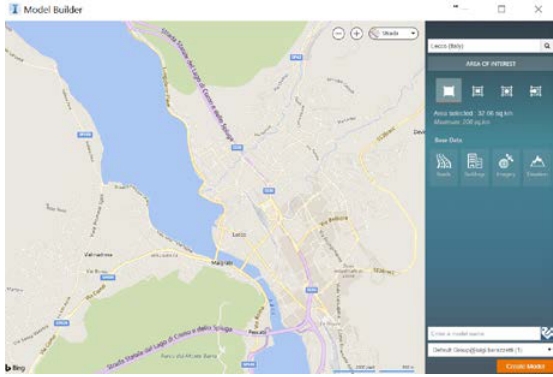
Figure 6. The graphical interface used to automatically retrieve geospatial data for the Lecco project (see next section).